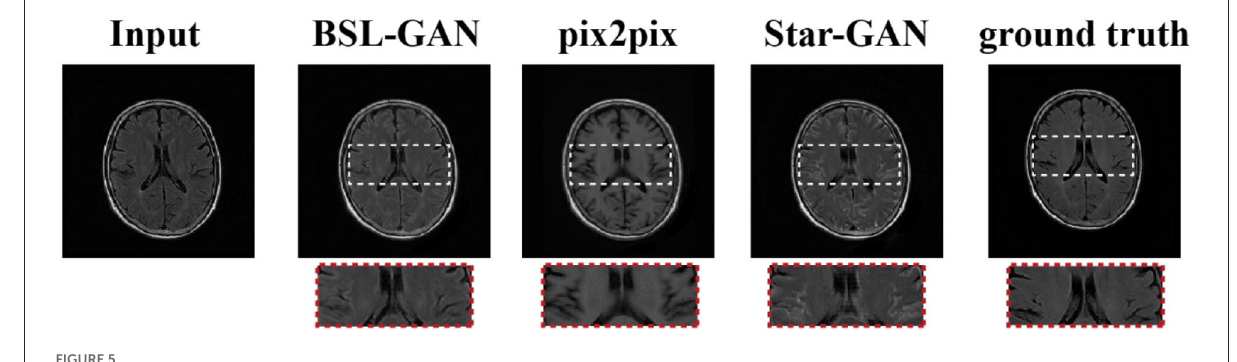
FIGURE5 Task of 1.5T MRI to 3T MRI.